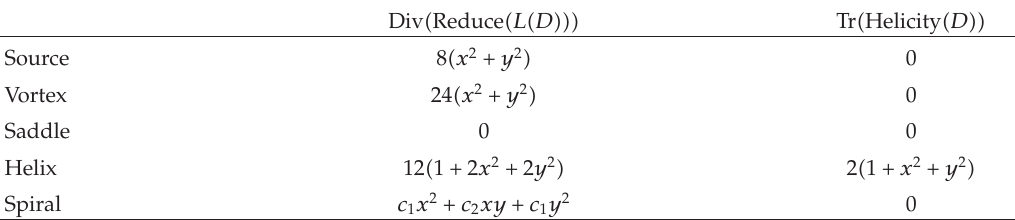
Table 4: Detecting saddles and helices in second-order tensor fields.